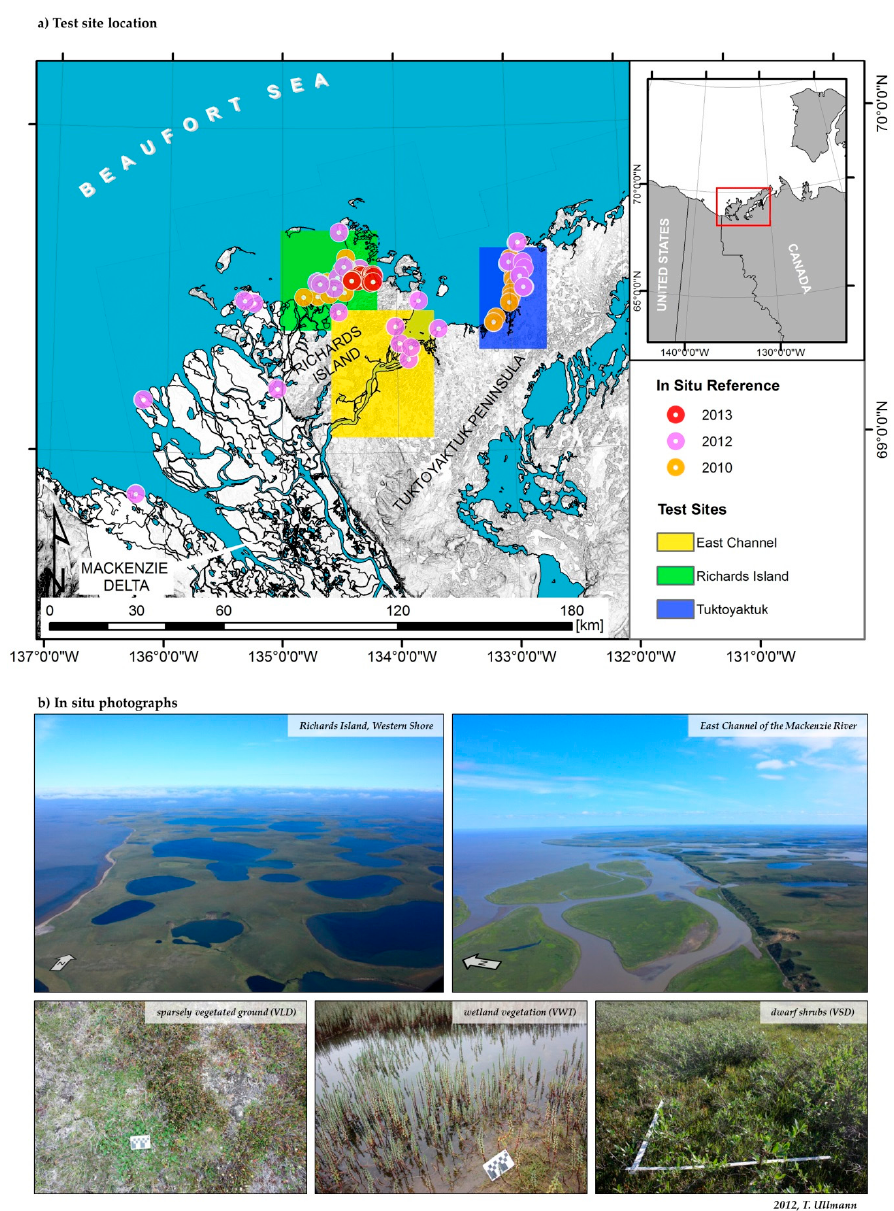
Figure 1. Test site location: ( a ) Extent of the investigation areas, locations of the in situ field work and ( b ) field photographs of frequent land cover classes. The background map in ( a ) shows the topographic slope derived from intermediate TanDEM-X elevation model data provided by DLR (2012, German Aerospace Center); grey color indicates sloped terrain. Extents of the test sites refer to the common image footprints of the SAR acquisitions of TerraSAR-X/TanDEM-X and Radarsat-2.